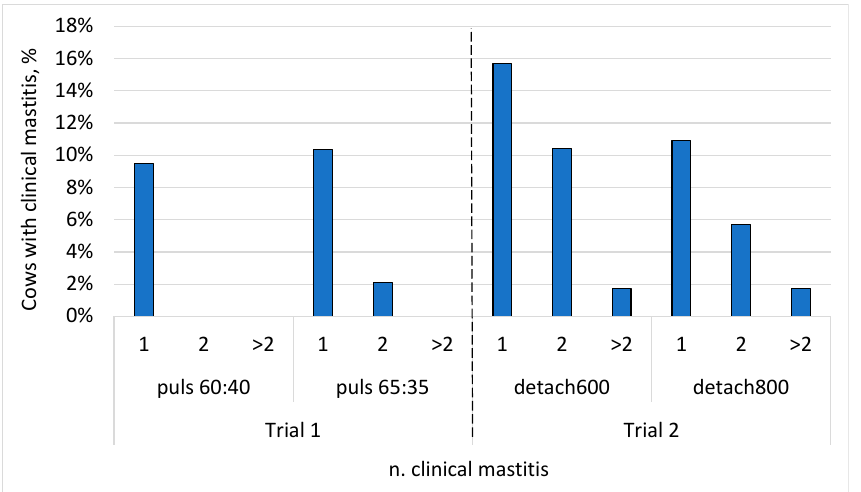
Figure 1. Percentage of cows with clinical mastitis infection during the experimental period, distin- guished between Trial 1 (puls60:40 vs. puls 65:35) and Trial 2 (detach600 vs. detach800). The number of cases of clinical mastitis was 1, 2, or >2.